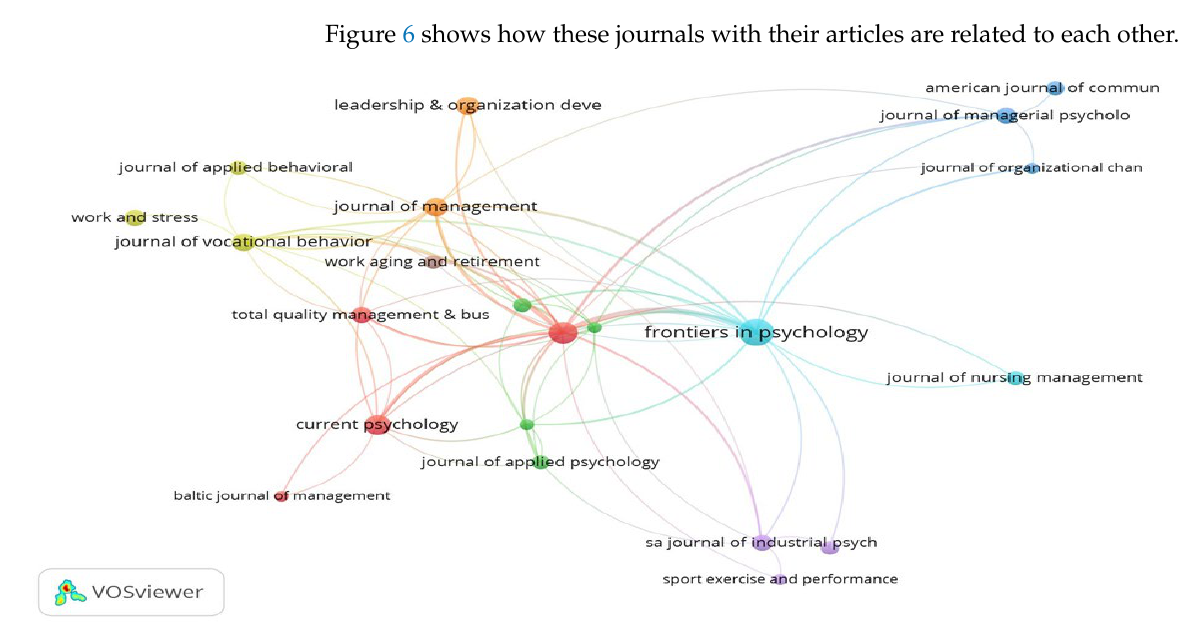
Figure 6. The most cited journals and the links between them.